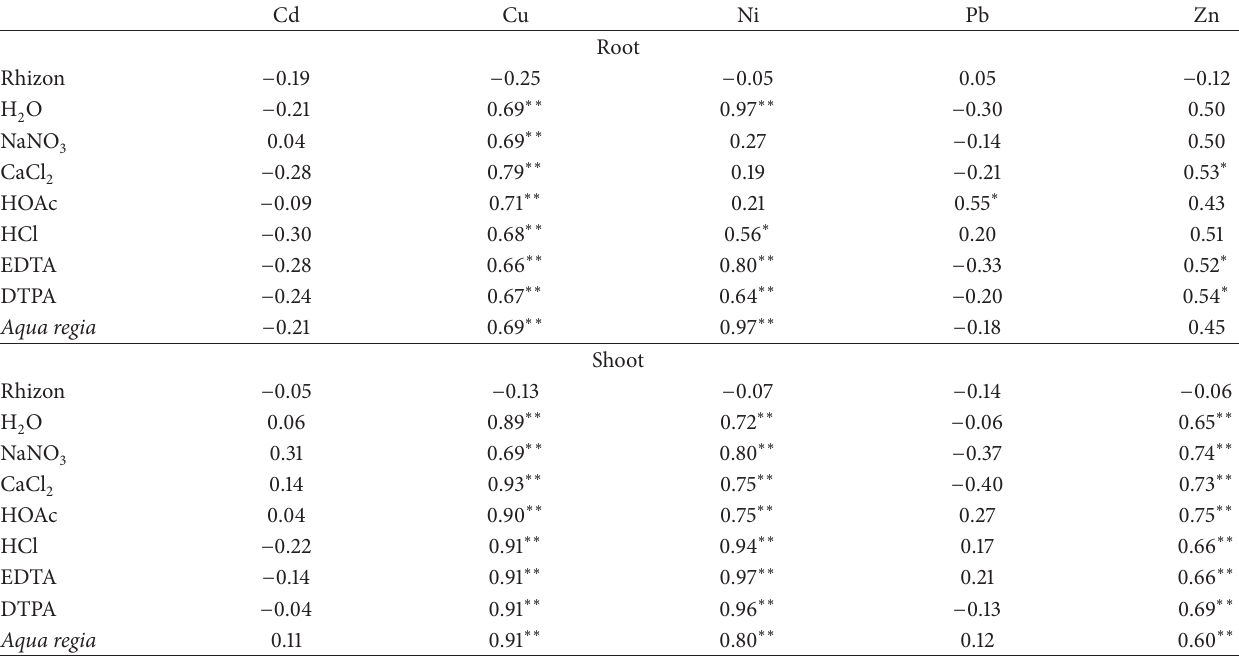
Table 6: Pearson linear correlation coefficients between heavy metal extracted from the soil with different extraction methods and concentrations in the root and shoot of Chinese cabbage ( 𝑛 = 17 for Cd and Pb; 𝑛 = 18 for Cu, Ni, and